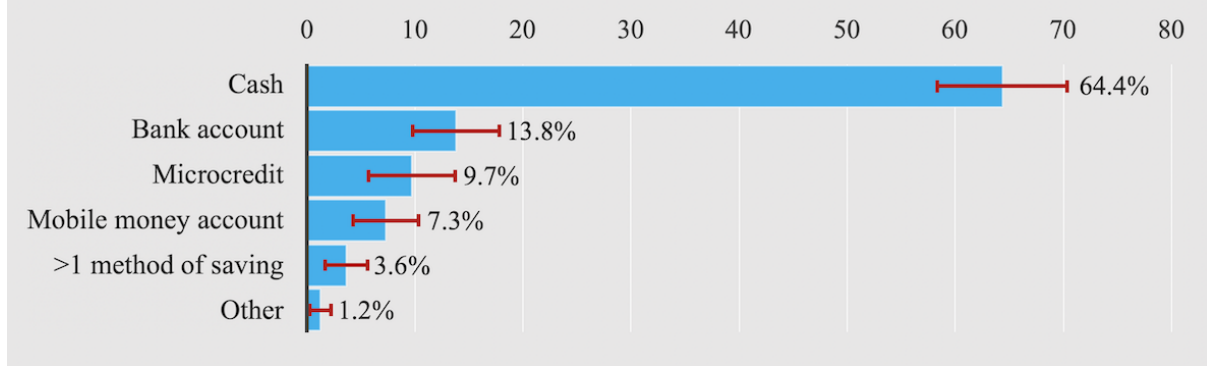
Figure 1. Saving methods among pregnant women and new mothers in Antananarivo (Atsimondrano and Renivohitra districts), Madagascar. N=247. Error bars represent 95% CIs.